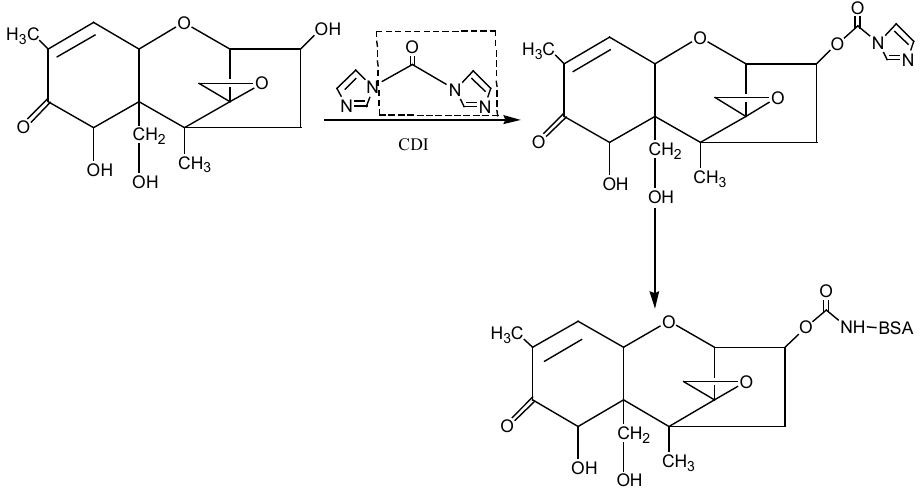
Figure 7. The synthesis route of DON-BSA by the CDI method. 2 (cid:13) 1-Ethyl-3-(3-dimethylaminopropyl)carbodiimide hydrochloride (EDC) method: The hapten (DON-HM) was synthesised by using the 3-hydroxy group of DON to react with the carboxyl group of MA to introduce the active group ( − COOH). Under the action of EDC, the introduced − COOH was coupled with the − NH 2 of the carrier protein BSA in the form of a monoamide bond ( − CONH − ) to synthesise the artificial antigen DON-BSA. For specific operation steps, refer to the EDC method described by Sun Zhen et al. [31], with improvements. The detection antigen DON-OVA was prepared by the same method. The synthesis route is shown in Figure 8. O